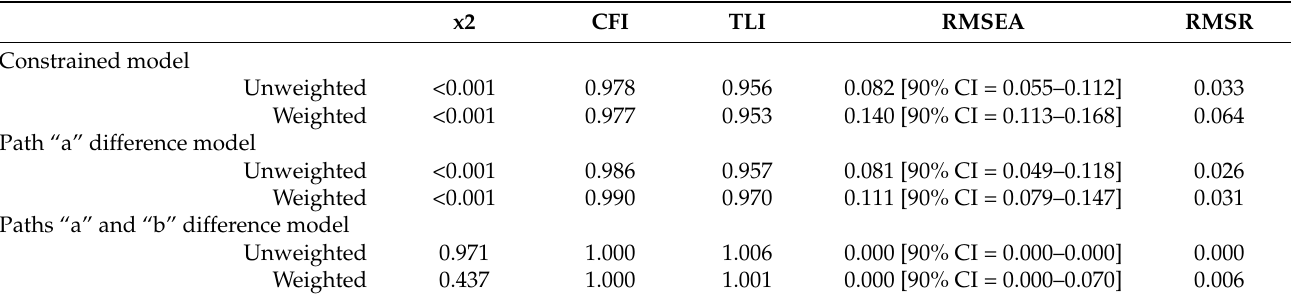
Table 3. Fit indexes for path analysis